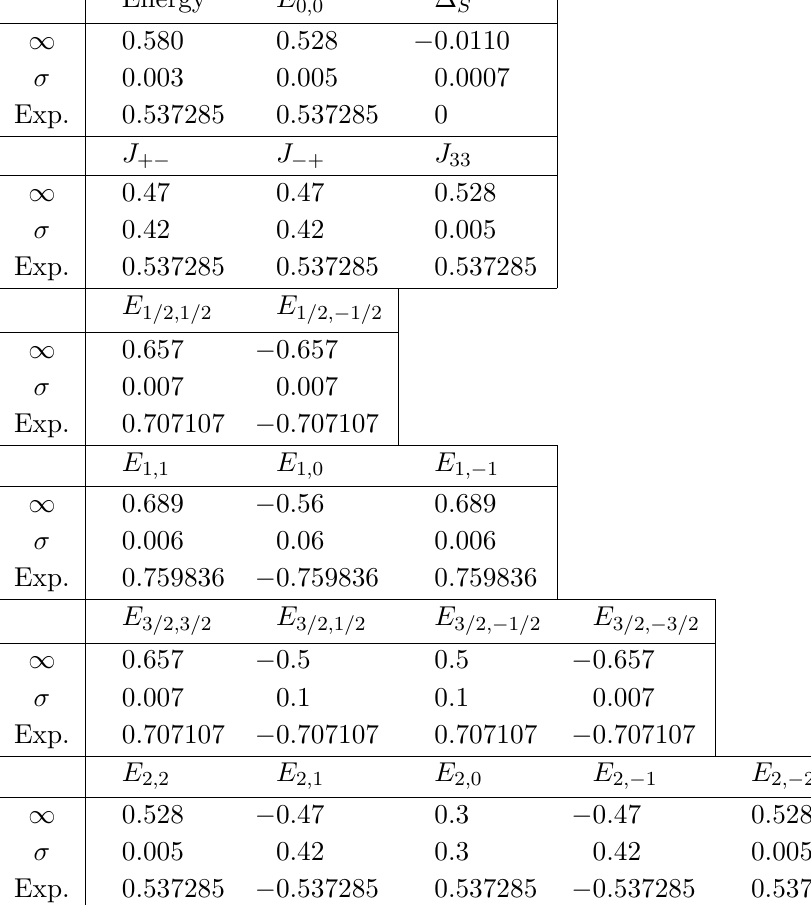
Table 9 . Extrapolations of gauge invariants of a solution probably describing 0 -brane with θ = 0 in the k = 4 model with J = 1 boundary conditions and their expected